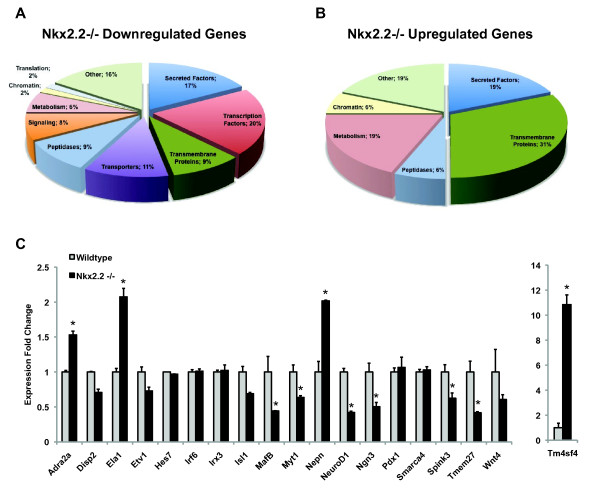
Categorization and confirmation of Nkx2.2-/- gene expression changes. (A, B) Gene changes categorized by gene ontology (GO) terms determined in Tables 1, 2, and 3. Quantification of downregulated (A) and upregulated (B) genes is represented as percentages when compared to total affected genes. (C) qRTPCR verification of genes of interest at e13.5. Genes are listed in alphabetical order, except Tm4sf4, which was graphed separately due to a larger y-axis data range. Error bars represent SEM and asterisks denotes statistical significance < 0.05. Wild type = grey bars, Nkx2.2-/- = black bars.